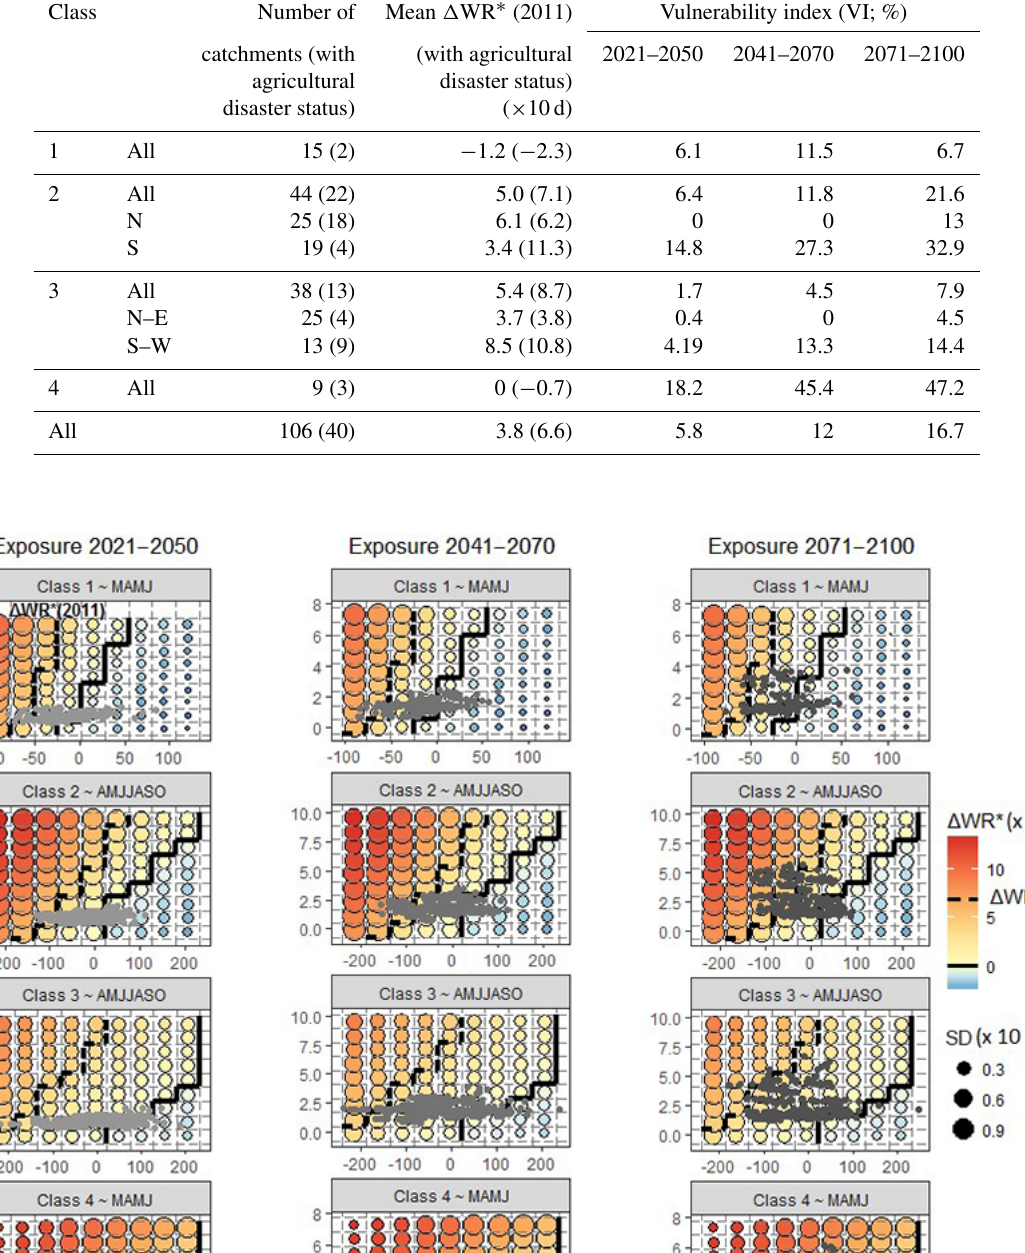
Hydrol. Earth Syst. Sci., 23, 3683–3710,